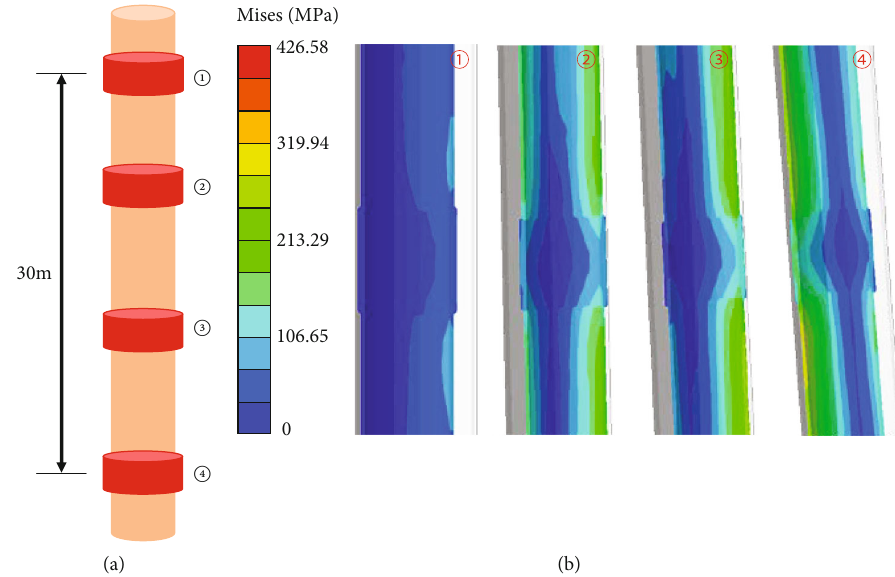
Figure 6: (a) Schematic diagram of casing string combination. (b) Cloud map of contact between the casing string and the wellbore wall.